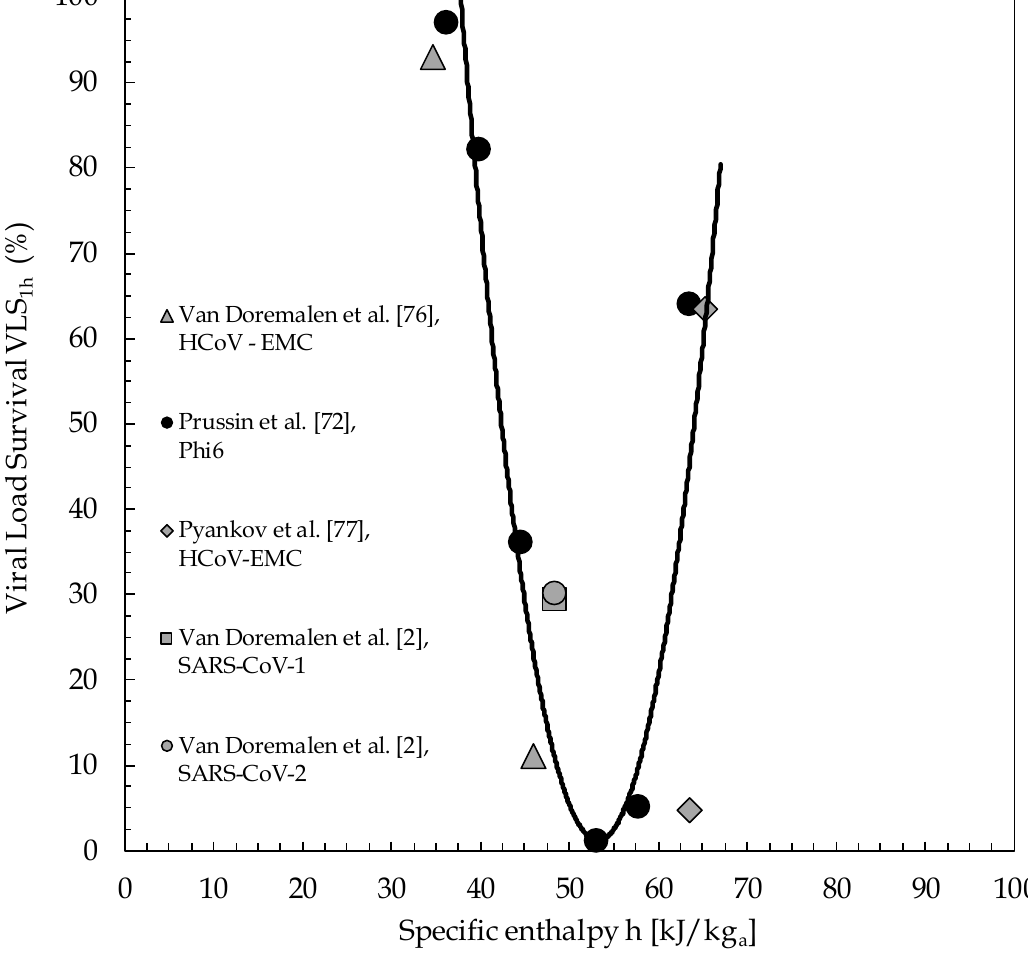
Figure 3. Viral load survival (VLS) 1h as a function of specific enthalpy h of moist air (kJ/kg-dry air).